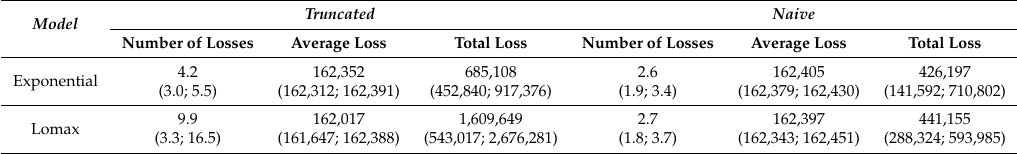
Table 8. Model-based predictions (with 95% confidence intervals in parentheses) of several statistics for the unobserved losses between $150,000 and